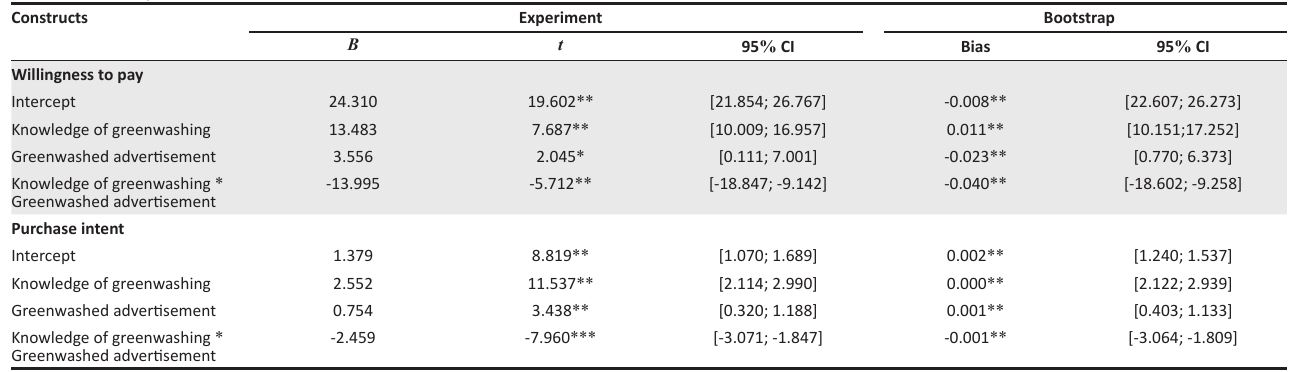
TABLE 3: Bootstrap results.